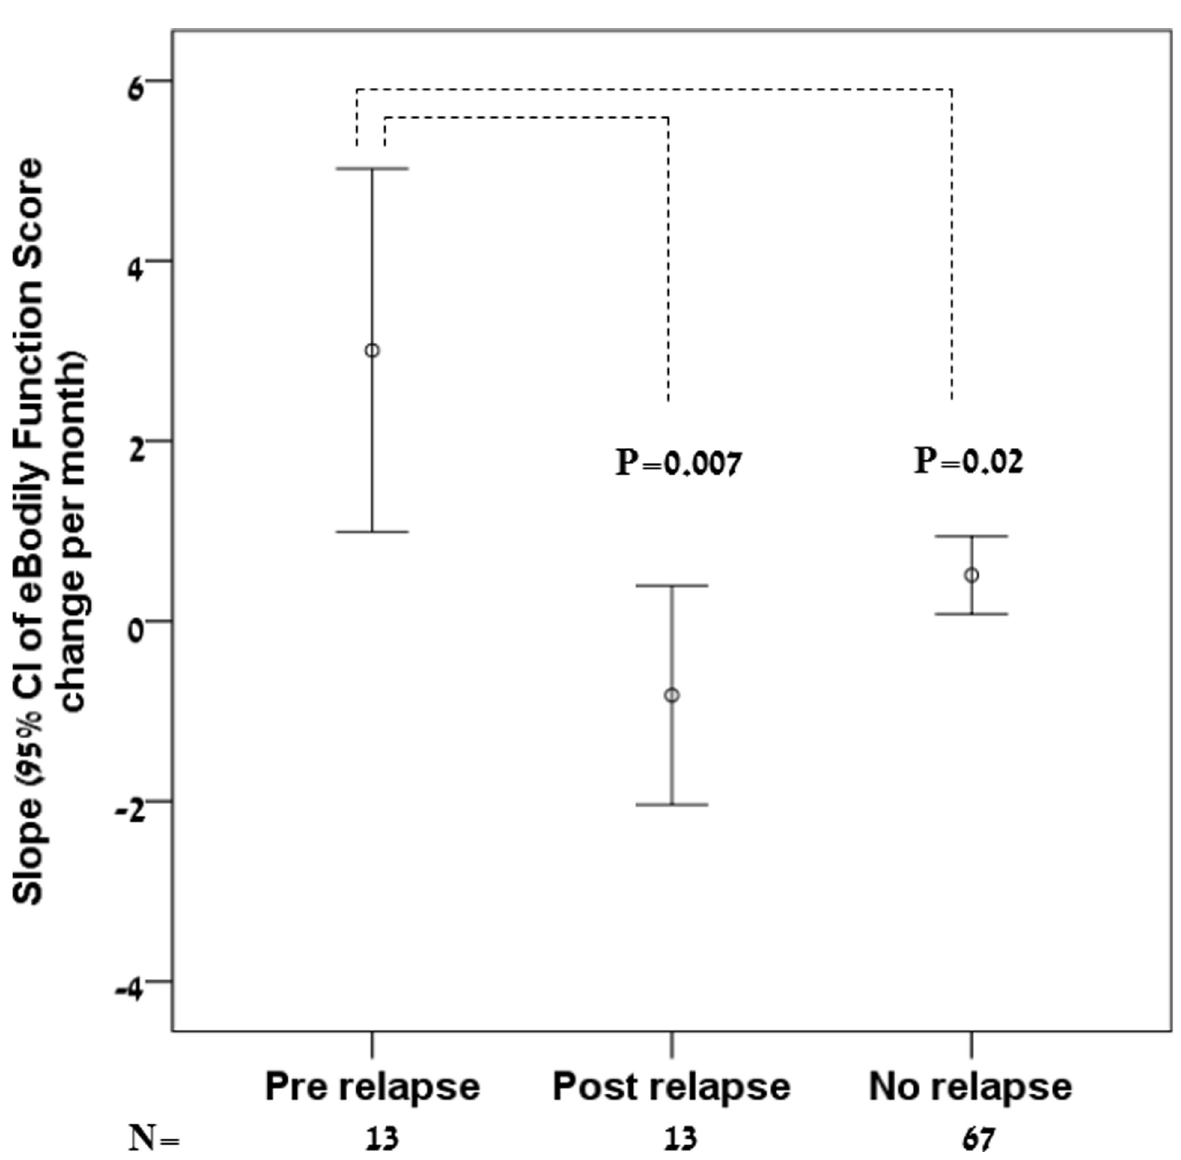
Fig 4. Distribution of individual regression slopes of the sum of bodily function scores (eBF). 13 patients had a relapse during the study. The average pre-relapse slopes were positive (indicating worsening), while post-relapse slopes were negative on average (indicating improvement). Individual regression slopes of patients who did not relapse during the study were close to zero. P value for the comparison between pre-relapse and post-relapse regression slopes is from a paired t-test. P value for the comparison between pre-relapse regression slopes and regression slopes of patients without clinical MS relapses is from an independent group